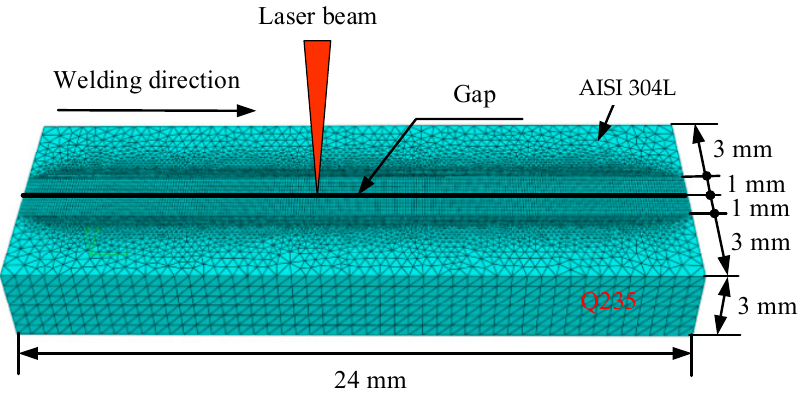
Figure 2. The sketch of the simulation setup.